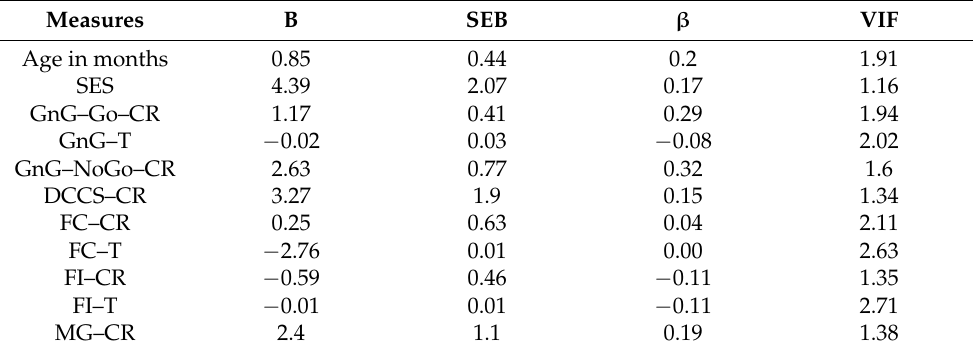
Table 4. Regression coefficients for all EF predictors and covariates on the learning prerequisites (IPDA scores).